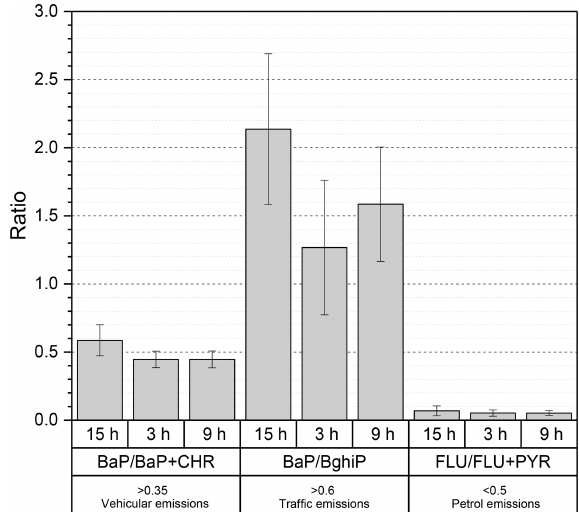
Figure 4. Column distribution of BaP / BaP + CHR, BaP / BghiP and FLU / FLU + PYR in the particulate phase for three different sampling periods. 3 and 9h represent samples collected during the day, and 15h represents samples at night. Error bars reflect standard